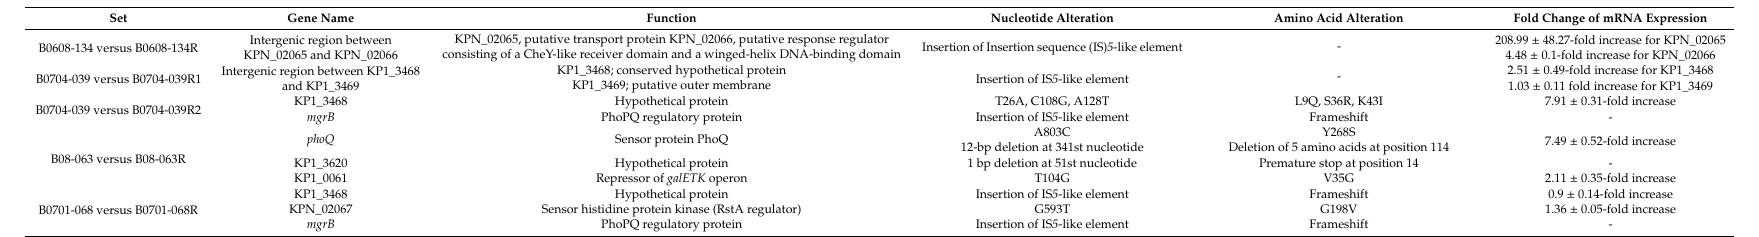
Table 2. Nucleotide and amino acid alterations and mRNA expression changes among five pairs of isogenic Klebsiella pneumoniae